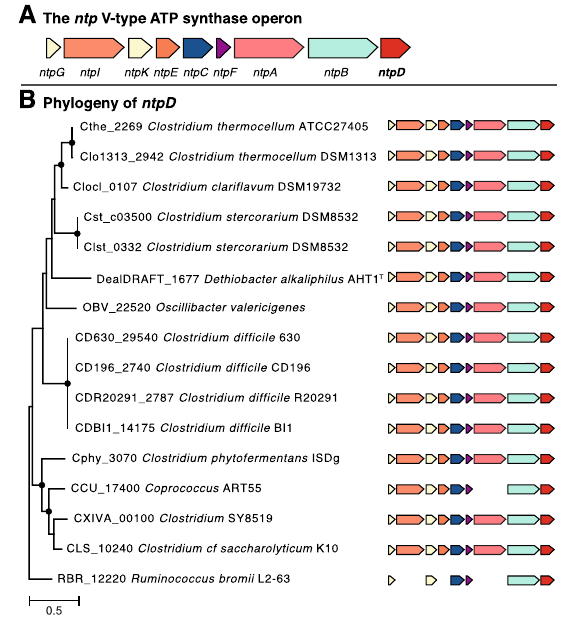
Fig. 5 a The ntp Vacuole-type ATP synthase operon structure. b 93 ntpD homologs (DealDRAFT_1677) within the genus Clostridia were aligned in Clustal Omega [34] and an unrooted neighbour-joining tree was generated in MEGA-6 [49]. From this tree, we picked the branch that contained the D. alkaliphilus AHT1 T ntpD sequence and computed a new neighbourjoining tree with gene DCR20291_1119 as an outgroup. The scale bar indicates a 0.5% sequence difference and conserved gene neighbourhoods of those genes were investigated using MGcV [50]. Large dots at the tree nodes indicate a bootstrap value of >85 (1000